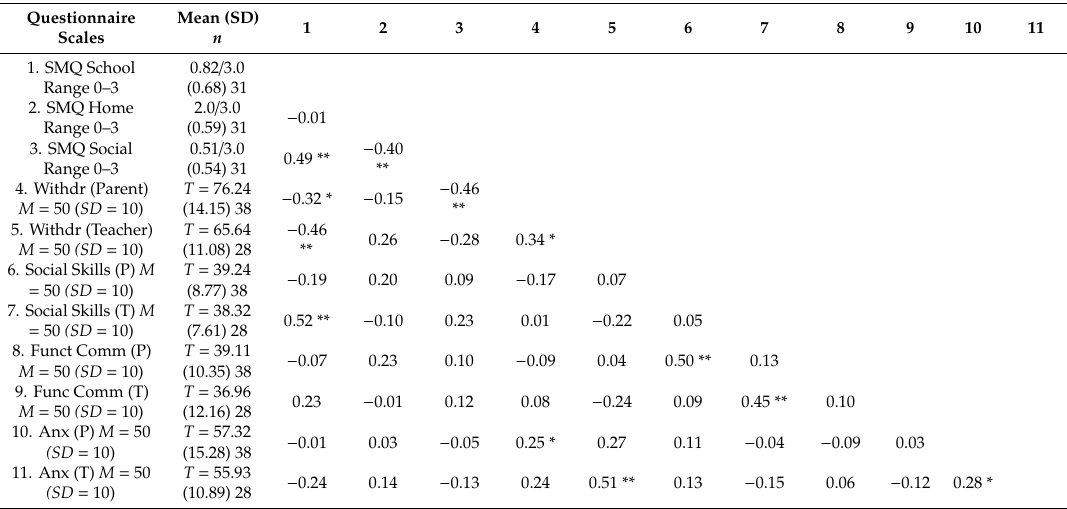
Table 2. Kendall’s tau-b correlations for BASC-3 scales (Mean = 50, SD = 10) and Selective